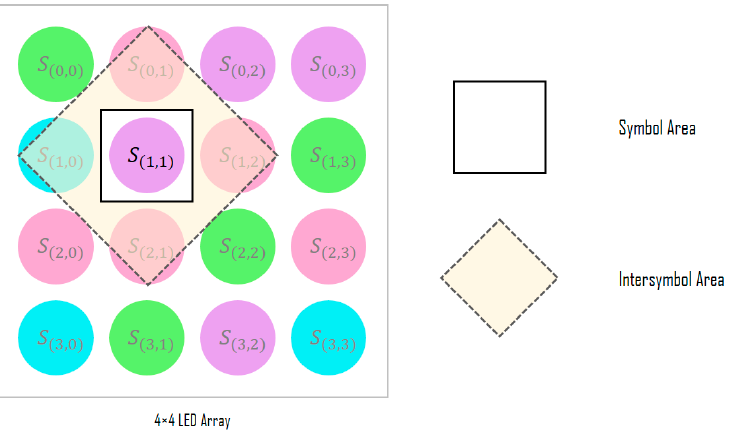
Figure 4. Adjacent symbol area used for symbol decision.